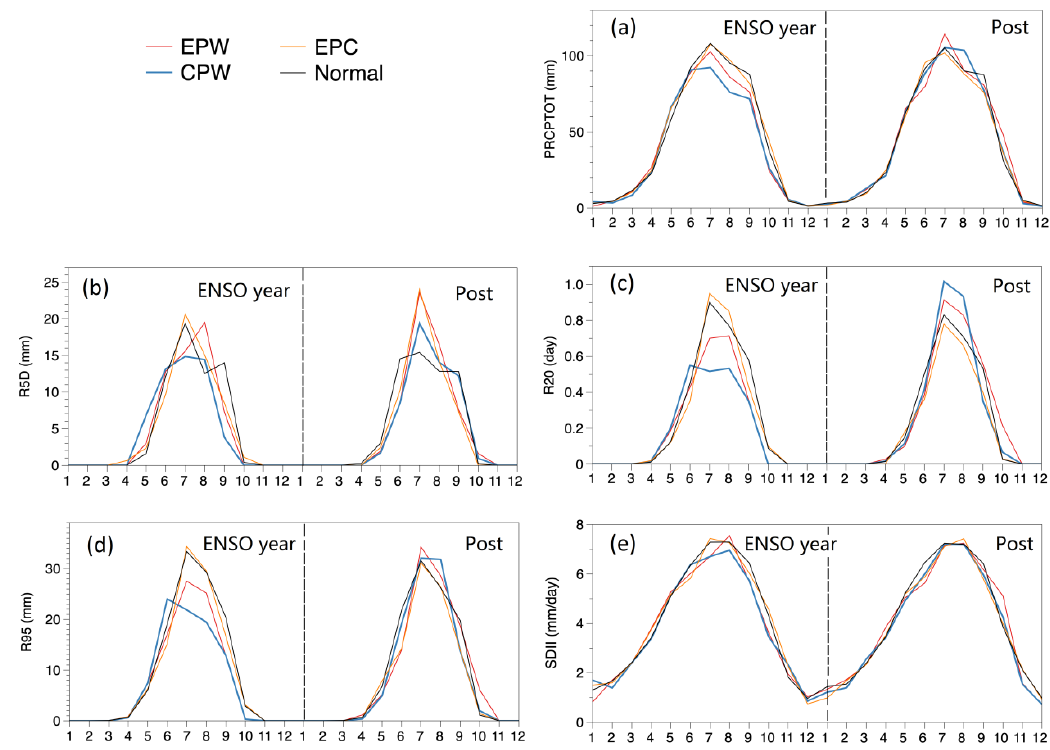
Figure 6. Monthly extreme precipitation indices in and after an ENSO year. ( a ) represents SDII; ( b ) represents PRCPTOT (total precipitation); ( c ) represents R95; ( d ) represents R5D; ( e ) represents